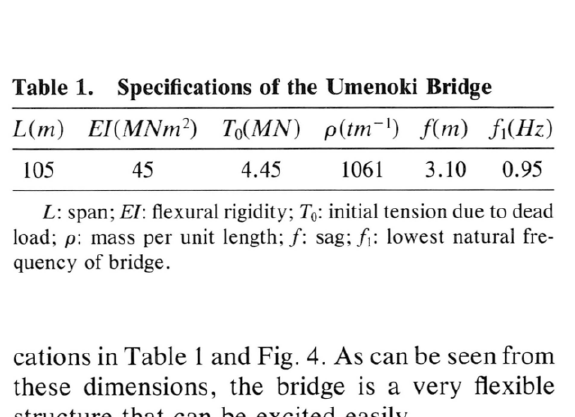
FIGURE 5 The Umenoki Bridge.